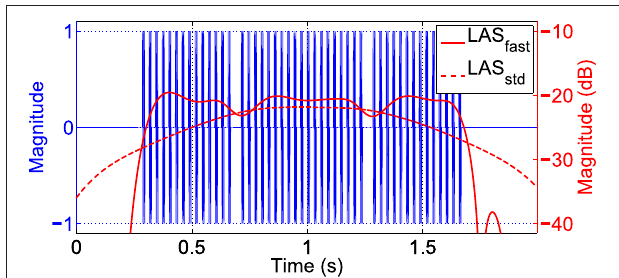
FIGURE 5 | Effect of twitches in an ideally simulated 35Hz stimulation signal. Logarithmic LAS features were extracted at the stimulation frequency using a fast setting (4Hz bandwidth, no MAV filter; red solid line) or standard setting (2Hz bandwidth, 1s MAV filter; red dashed line). With the fast setting, effects of twitches are clearly visible as attenuations of the LAS amplitude at twitch